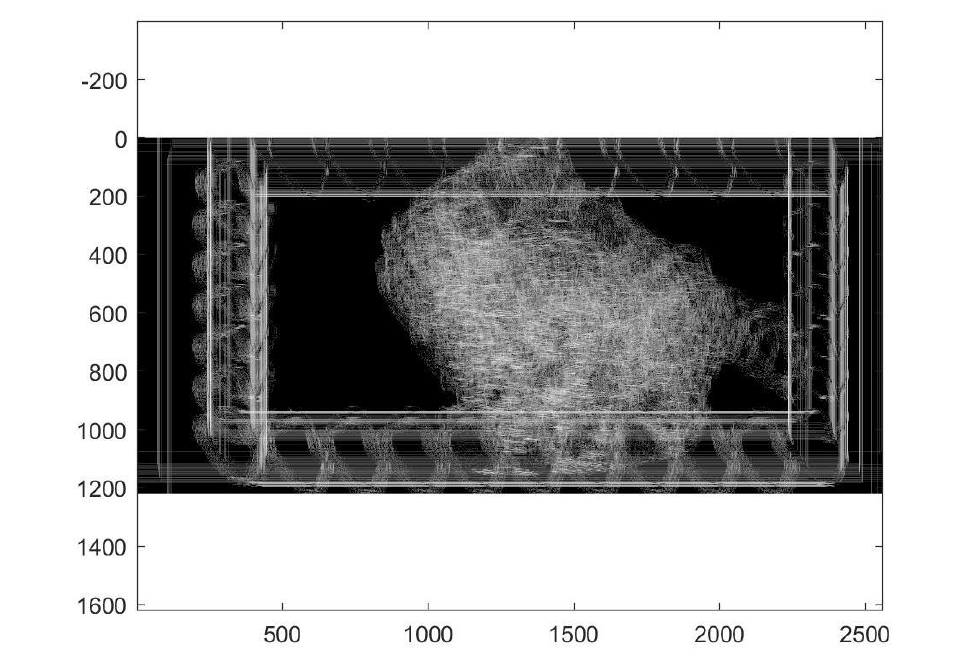
Figure 7. Restricted accumulator